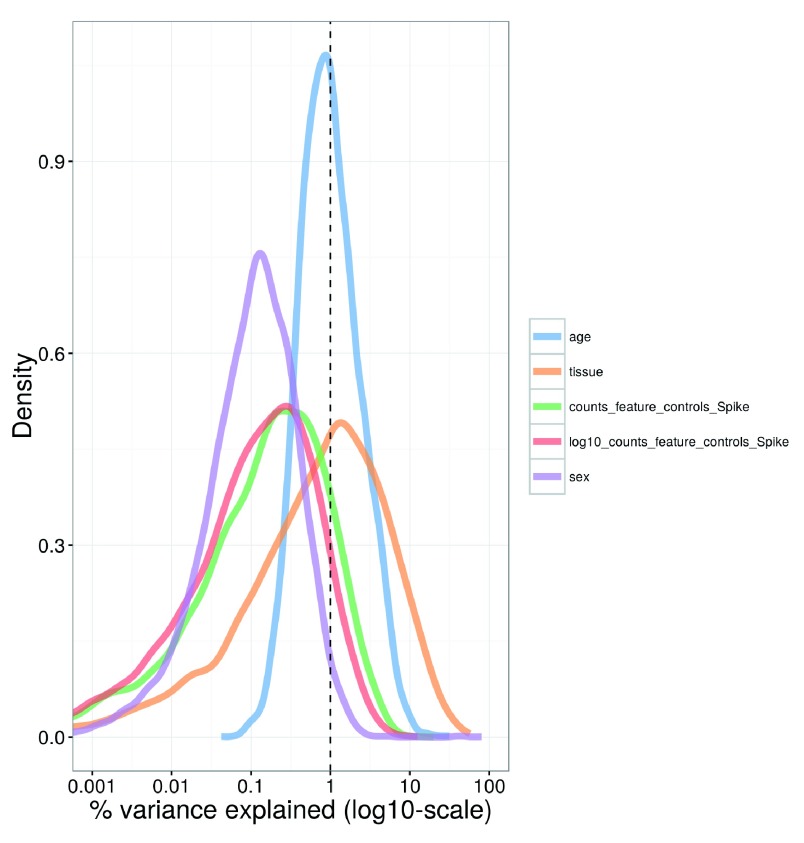
Density plot of the percentage of variance explained by each factor across all genes in the brain dataset.For each gene, the percentage of the variance of the normalized log-expression values that is explained by the (log-transformed) total spike-in counts, the sex or age of the mouse, or the tissue of origin is calculated. Each curve corresponds to one factor and represents the distribution of percentages across all genes.